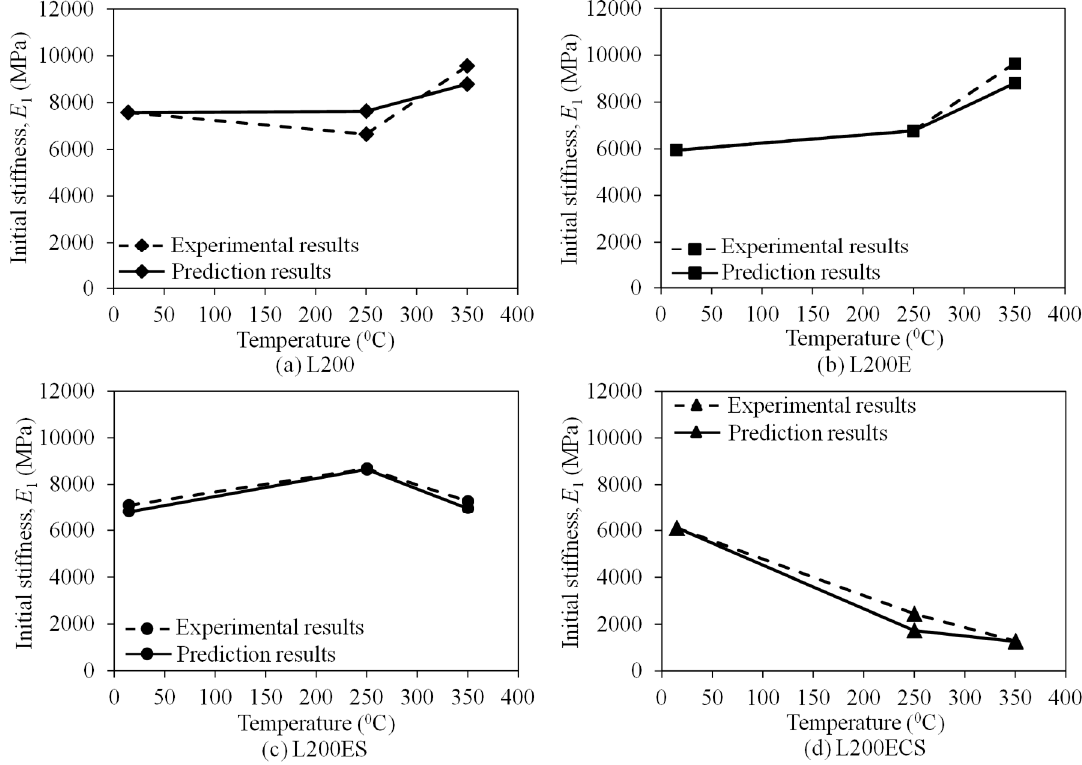
Figure 20. Predicted initial stiffness of the TRM specimens according to temperature.